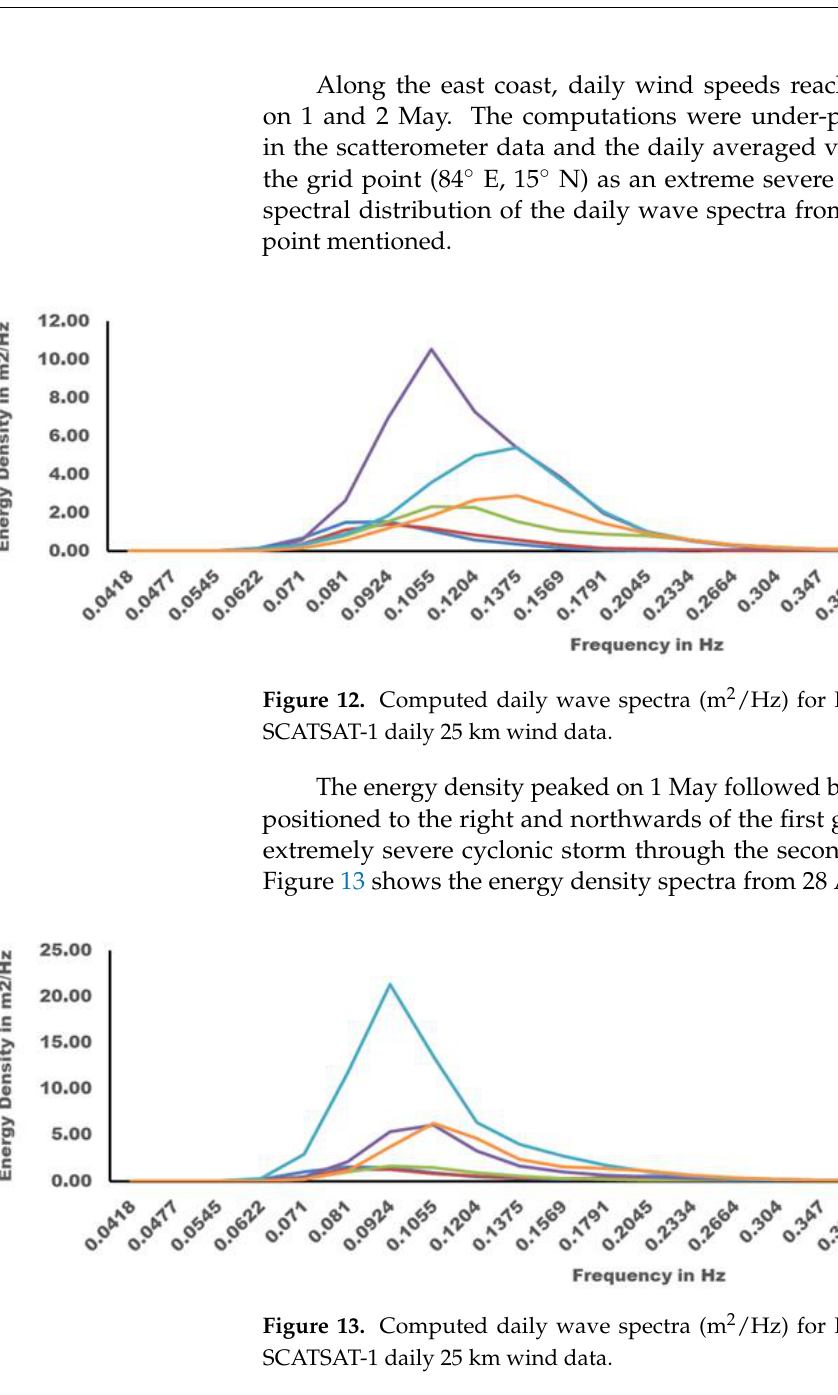
Figure 14. Mean winds (m/s) during BULBUL cyclone (7 – 10 November 2019) from SCATSAT − 1 (25 km) daily products.